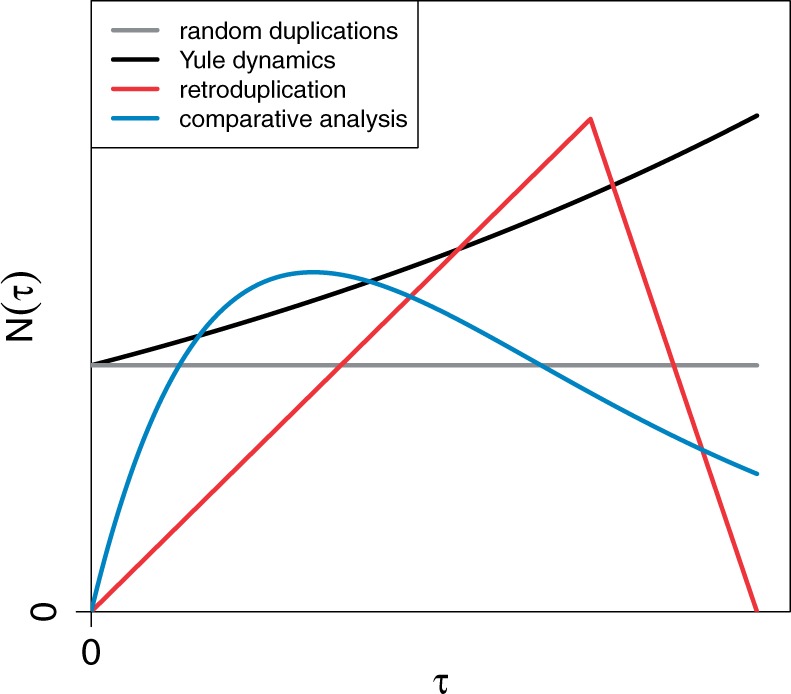
A schematic plot of the functions N(τ) for four different dynamical models of sequence evolution. As explained in the text, different ways of analyzing genomic data (either performing a self-alignment or aligning two genomes) or focusing on distinct compartments (e.g., retro-duplicated pseudogenes) lead to different distributions of pairwise distances between duplicated sequence segments. Only the behavior of N(τ) for small τ affects the exponent of the resulting power law α in the MLD. If N(τ=0)>0 (e.g., for the first two scenarios), the exponent is α=−3; if N(τ=0)=0, the exponent is α=−4. The functional forms of the first three scenarios are given in the article, the last one is a convolution of two exponential distributions (the exact functional form affects the exponent of the power law tail; see eq. 15).